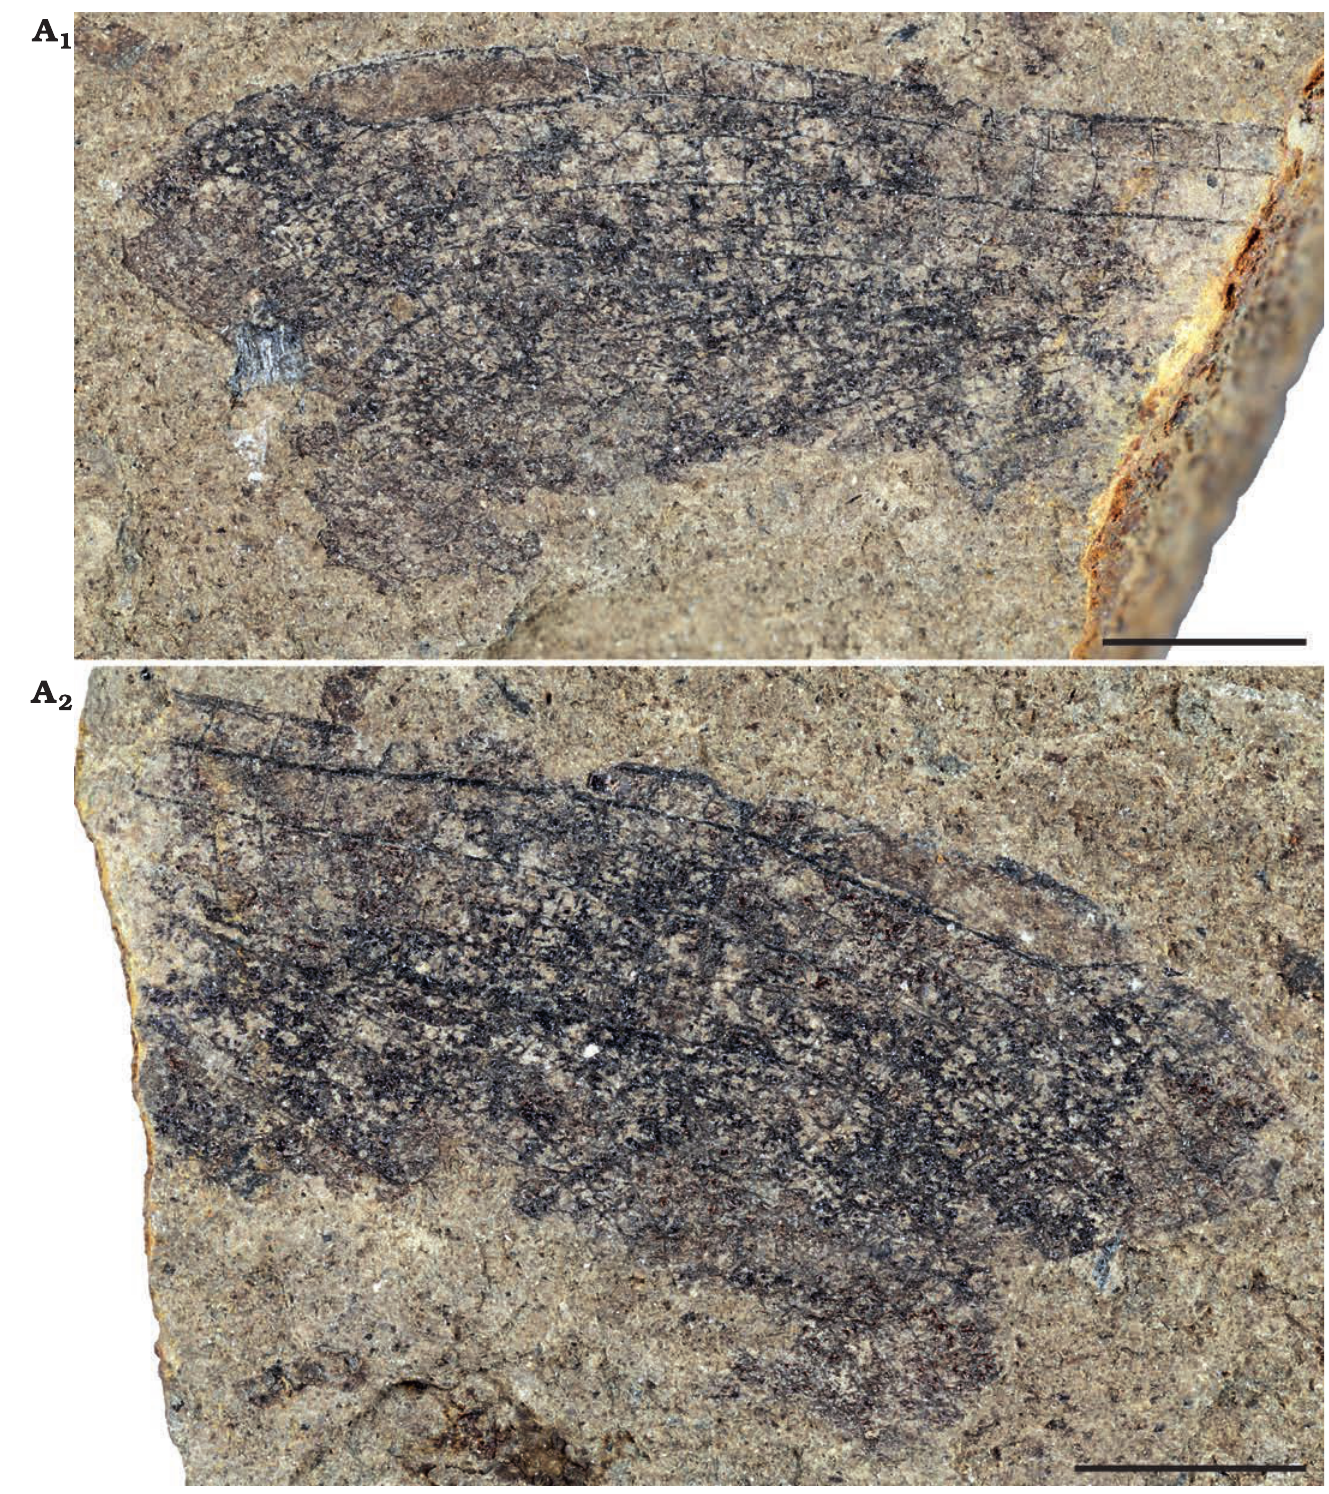
Fig. 6. Zygopteran odonatan Menatagrion hervetae gen. et sp. nov., MNHN ‘4/10/1973, Menat 63/64; from Paleocene, Menat, France. Imprint (A 1 ), counterimprint (A 2 ). Scale bars 2